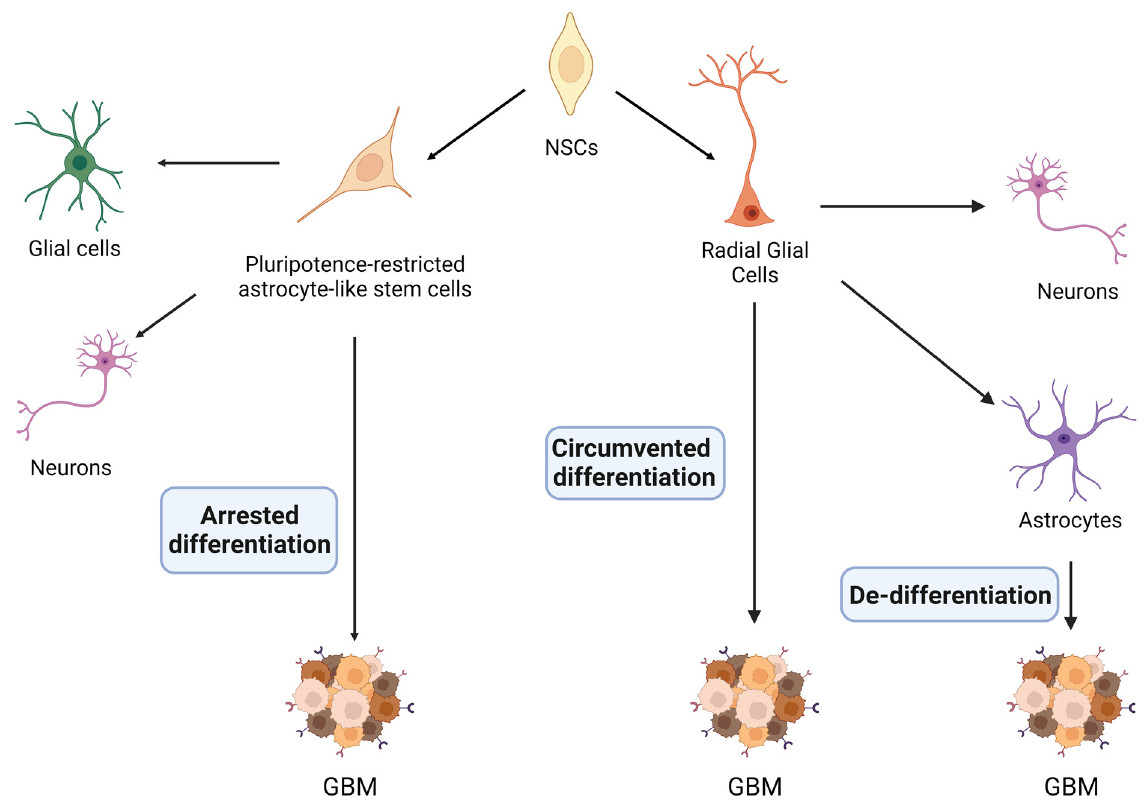
Figure 1. Putative mechanisms of GBM onset. During the embryonic development, neural stem cells (NSC) are able to differentiate in a broad phenotypic spectrum, gradually acquiring specialized cellular identities. Three main models have been proposed to explain the loss of cellular identity occurring during gliomagenesis: (i) De-differentiation model, in which de-differentiated cortical astrocytes represent the GBM cells-of-origin; (ii) Arrested Differentiation model, according to which the glioma-initiating cells are multipotent progenitor cells whose proper differentiation is blocked;